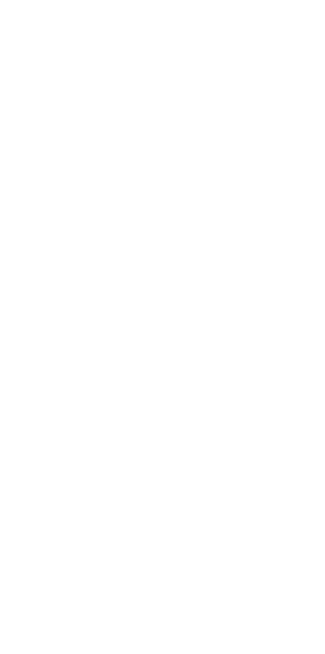
FIGURE 3 | Soil mineral distribution across the seven districts in Jharkhand.